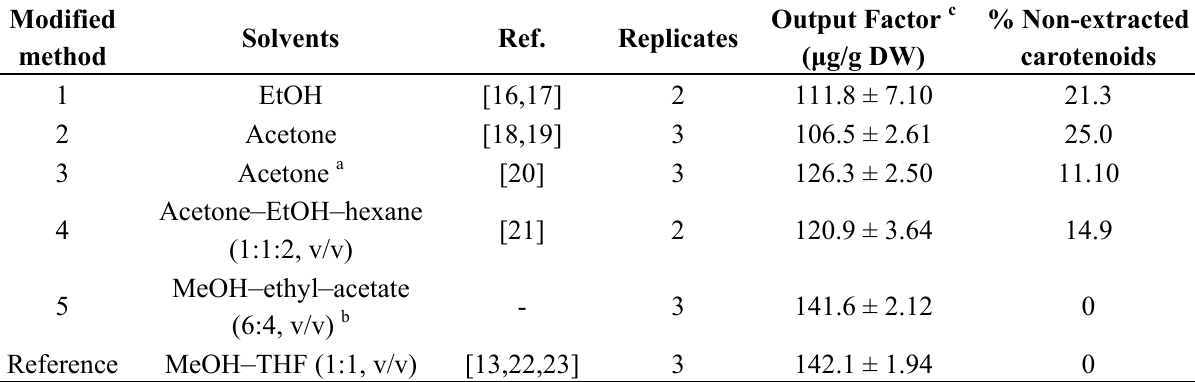
Table 1. Total carotenoids extracted from maize endosperm with the different solvent